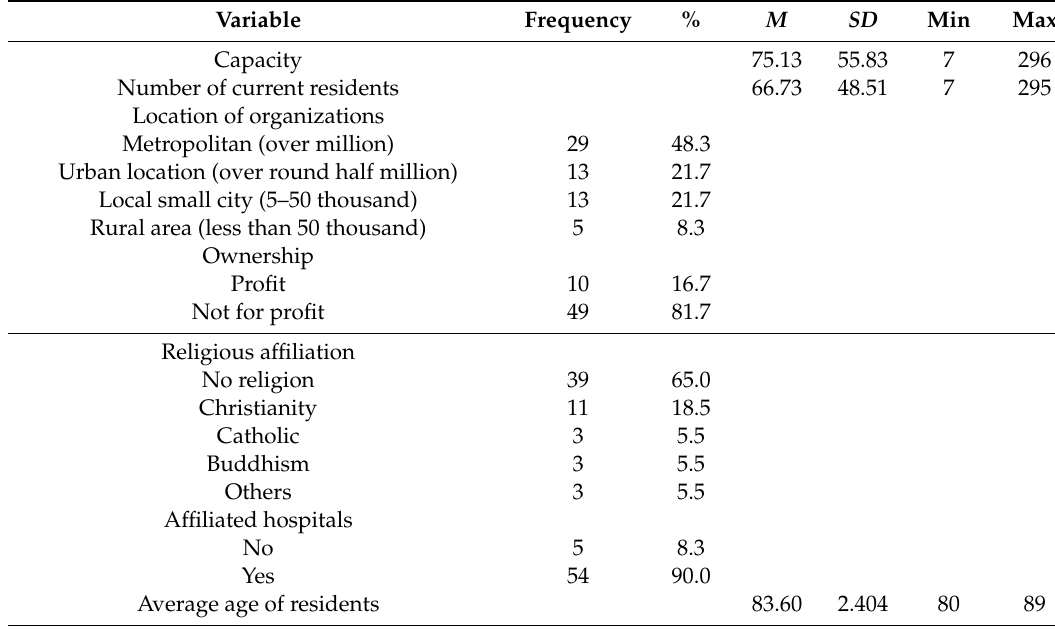
Table 3. Characteristics of Nursing Homes ( n =